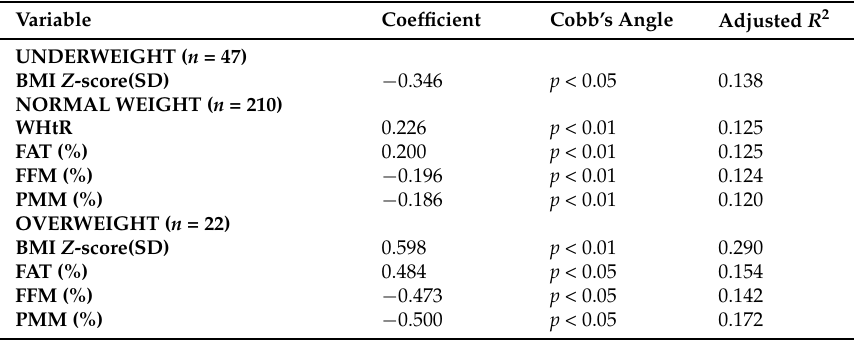
Table 4. Multivariate regression analysis of the variables influencing the curve magnitude among different anthropometrical status.